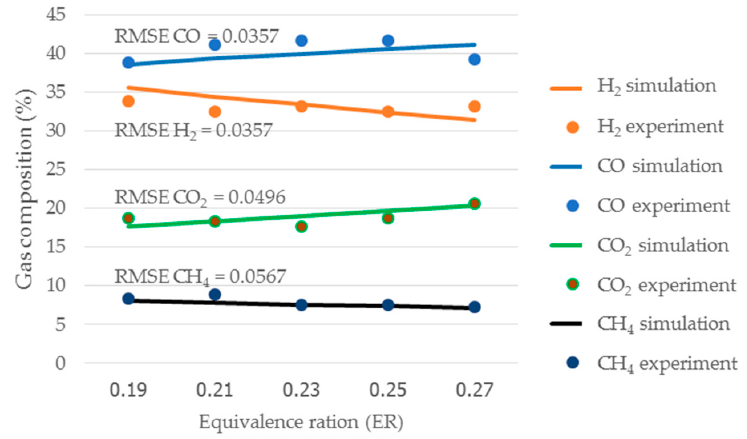
Figure 5. Experimental and simulation data comparison of gas composition with respect to equivalence ratio.